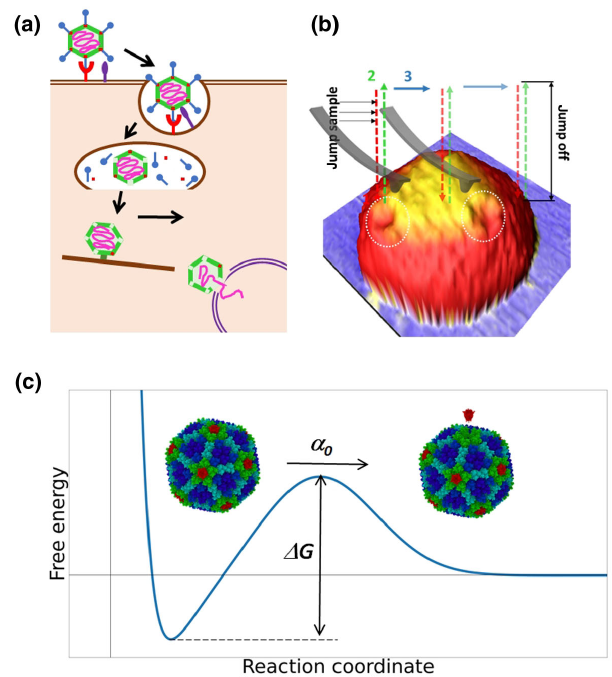
FIG. 1. Adenovirus in biological context, experimental and theoretical setups. (a) Ad5 infection. (b) AFM jumping mode. The tip approaches the sample (1), then withdraws (2), and moves laterally to the next pixel (3). Two missing pentons are shown (white circles). (c) Energetic profile of penton release process when two states are